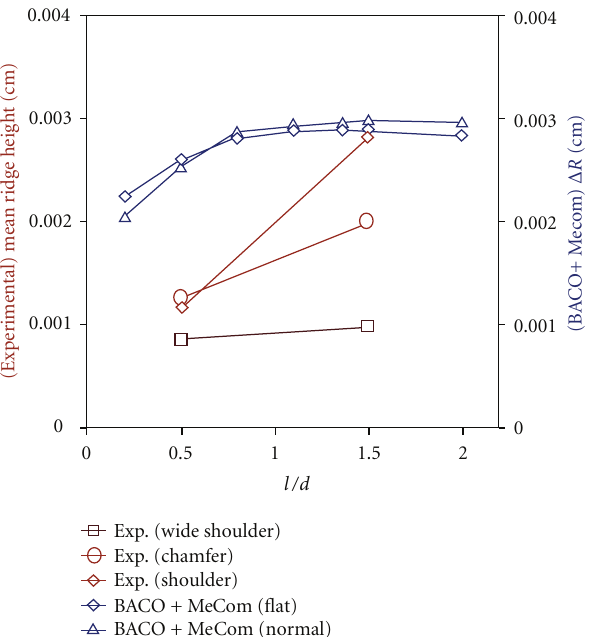
Figure 14: Correlation between experimental mean ridge height and radial deformation ( Δ R ) calculated by varying the “ l/d ”